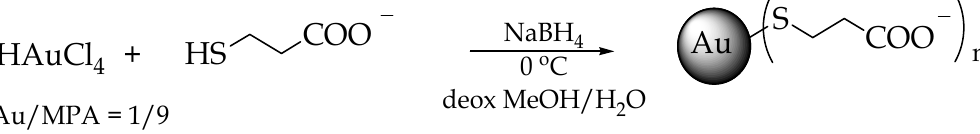
Figure 1. Scheme representing 3 ‐ mercaptopropionic acid ‐ coated AuNPs (MPA ‐ AuNP) synthesis.